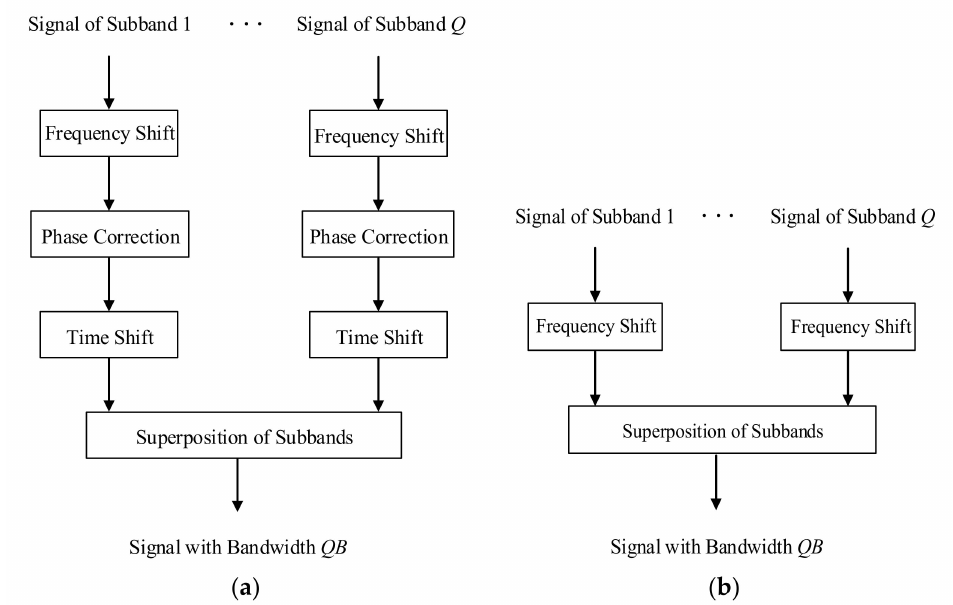
Figure 3. Comparison of two time domain bandwidth synthesis (TBS) methods. ( a ) Traditional TBS; ( b ) improved